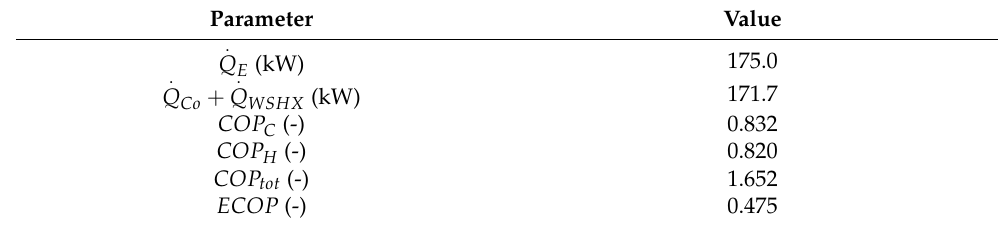
Table 3. Absorption heat pump performance for air conditioning application.